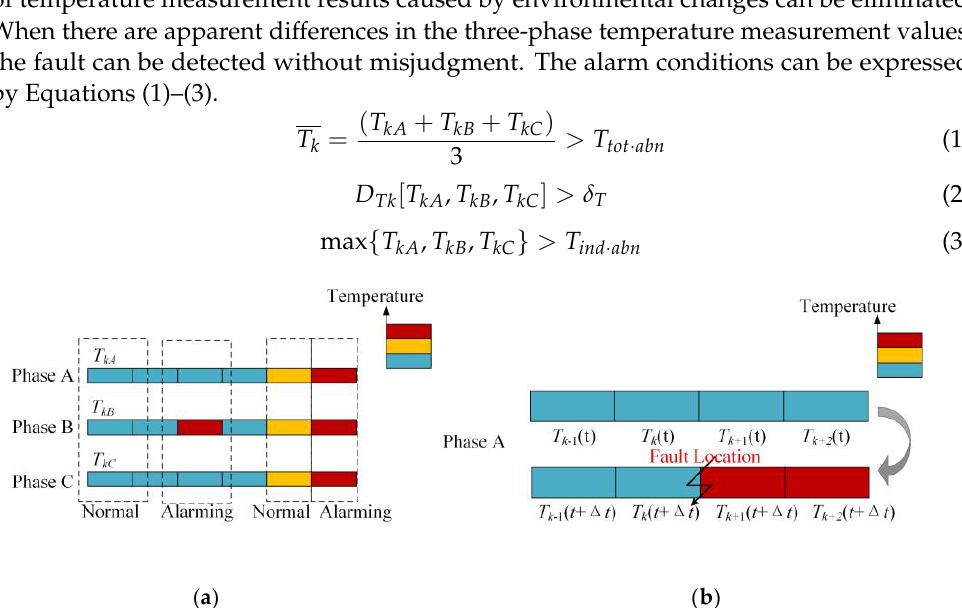
Figure 1. Schematic diagram of temperature along the cable. (Every block represents a single spatial interval of sampling and the relative value of temperature measurement is expressed in different colors; ( a ) is the comparison of three phases at the same time and location, and ( b ) is the comparison of single phase at different time and locations).